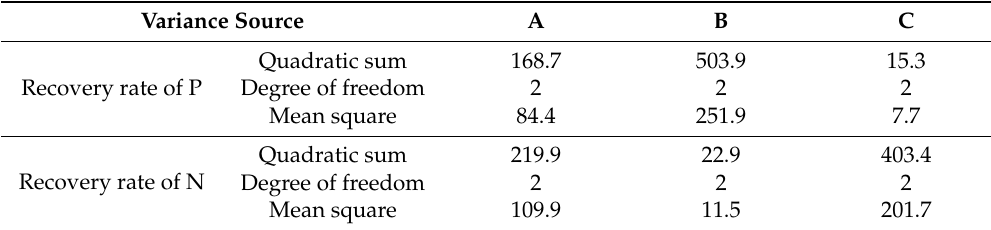
Table 3. Variance analysis of the experimental results.